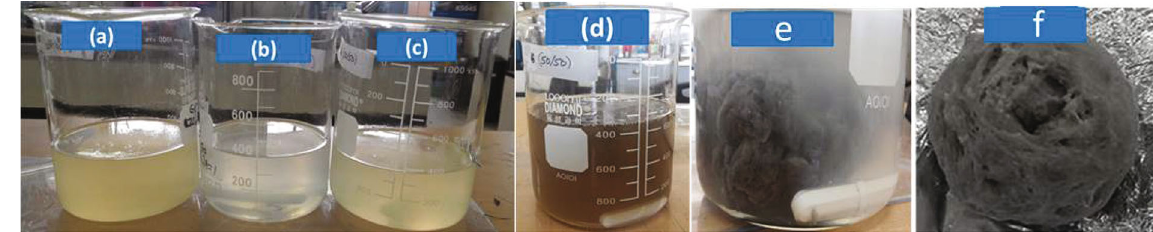
Figure 1: Solution processing of representative samples of N/E blends and their composites with GO and G; (a) 80/20, (b) 20/80, (c) 50/50, (d) 50/50-G solution, (e) coagulation of 50/50-G, and (f) 50/50-G nanocomposite after